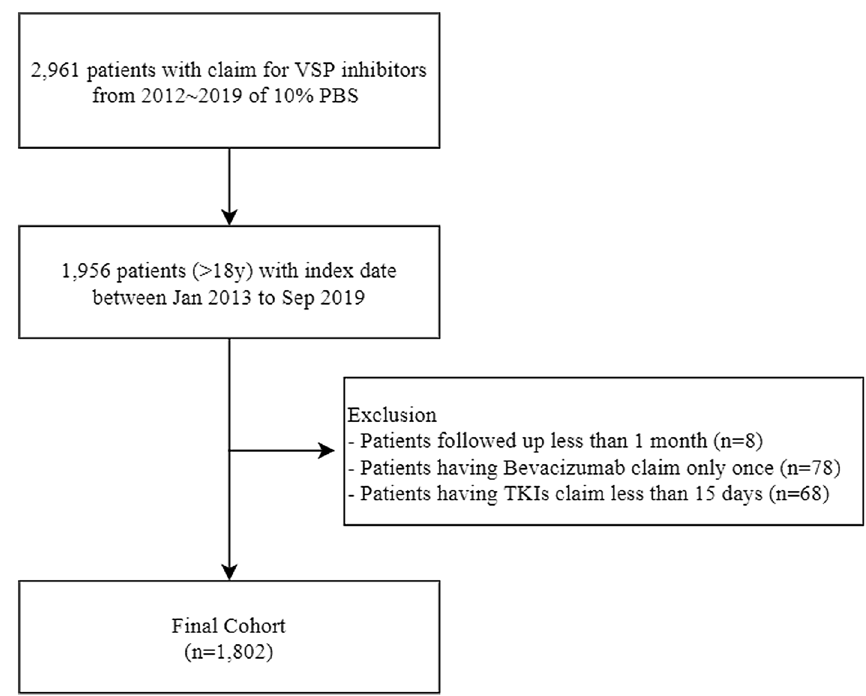
Fig. 1 Consort flow diagram of study